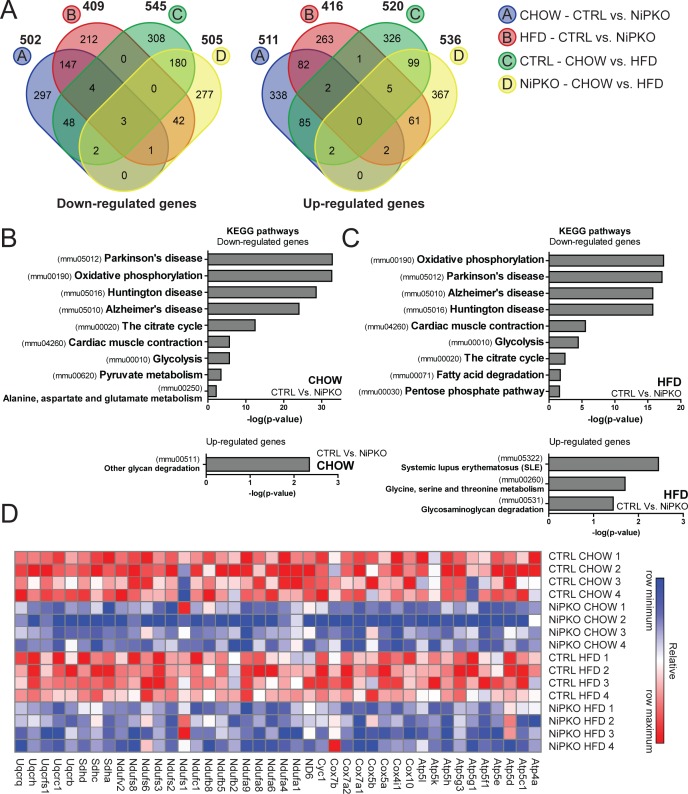
PGC-1α regulates transcription of mitochondrial and metabolic genes in kidney.(A) VENN diagrams displaying the number of unique or overlapping down- or up-regulated genes (p<0.05 and fold change >1.2 cut-off) in either chow- or HFD-fed control (CTRL) or NiPKO mice. (B-C) Top significant terms for KEGG pathway enrichment analysis of down- or up-regulated genes in kidneys from (B) chow- fed NiPKO mice compared to CTRL mice or in (C) HFD-fed NiPKO mice compared to CTRL mice. (D) Heat map generated using probe set intensities for transcripts associated with the KEGG-category “Oxidative phosphorylation” in Fig B and C, for CHOW and HFD-fed CTRL and NiPKO mice. Row minimum = -3, row maximum = 3 fold change.